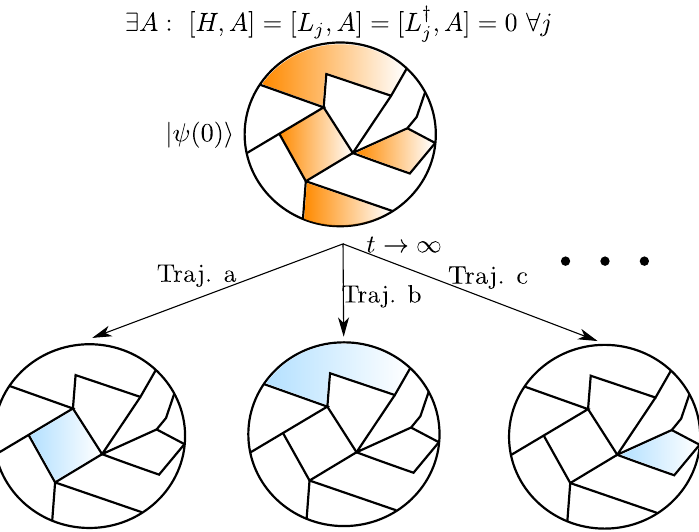
Figure 1: Dissipative Freezing: The Hilbert space of an open quantum system frag- ments into a series of subspaces in the presence of a strong symmetry operator A . For an initial state in a superposition of states in these different subspaces the long-time dynamics of a single quantum trajectory will almost always involve a ‘freezing’ into one of these subspaces selected at